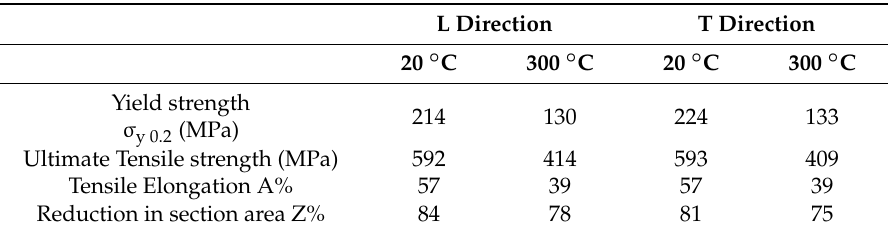
Table 1. Tensile properties of the CLI cast 304L stainless